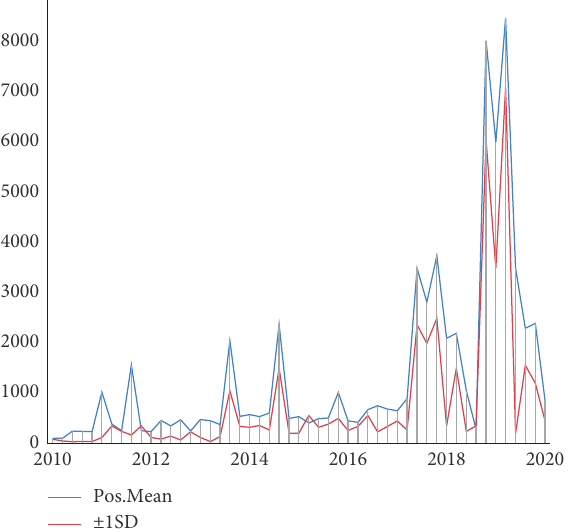
Figure 10: Time-varying features of stochastic price volatility of commodity price under the impact of economic policy